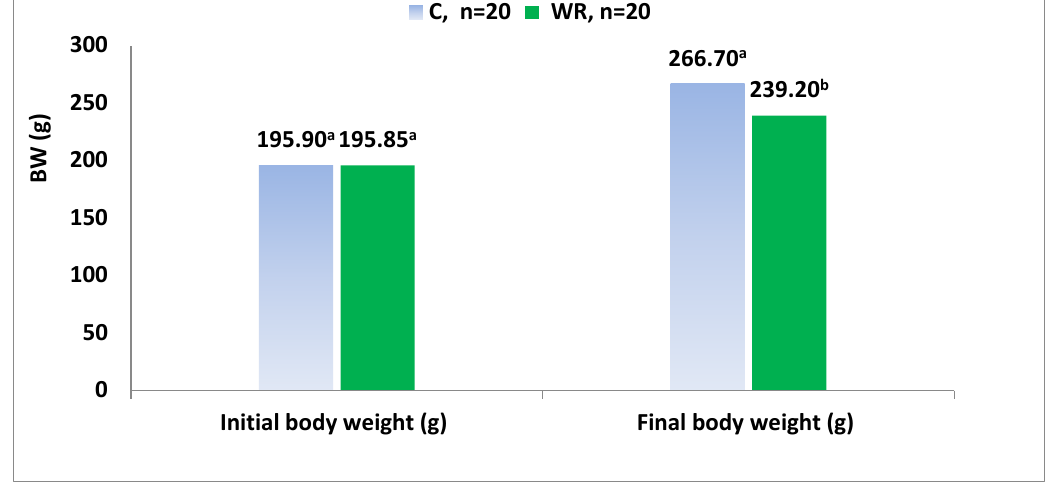
Figure 2. Initial and final body weights of pregnant dams in each group. Bars marked with different letters differ significantly ( p < 0.05); values that are marked with the same letter are not significantly different.